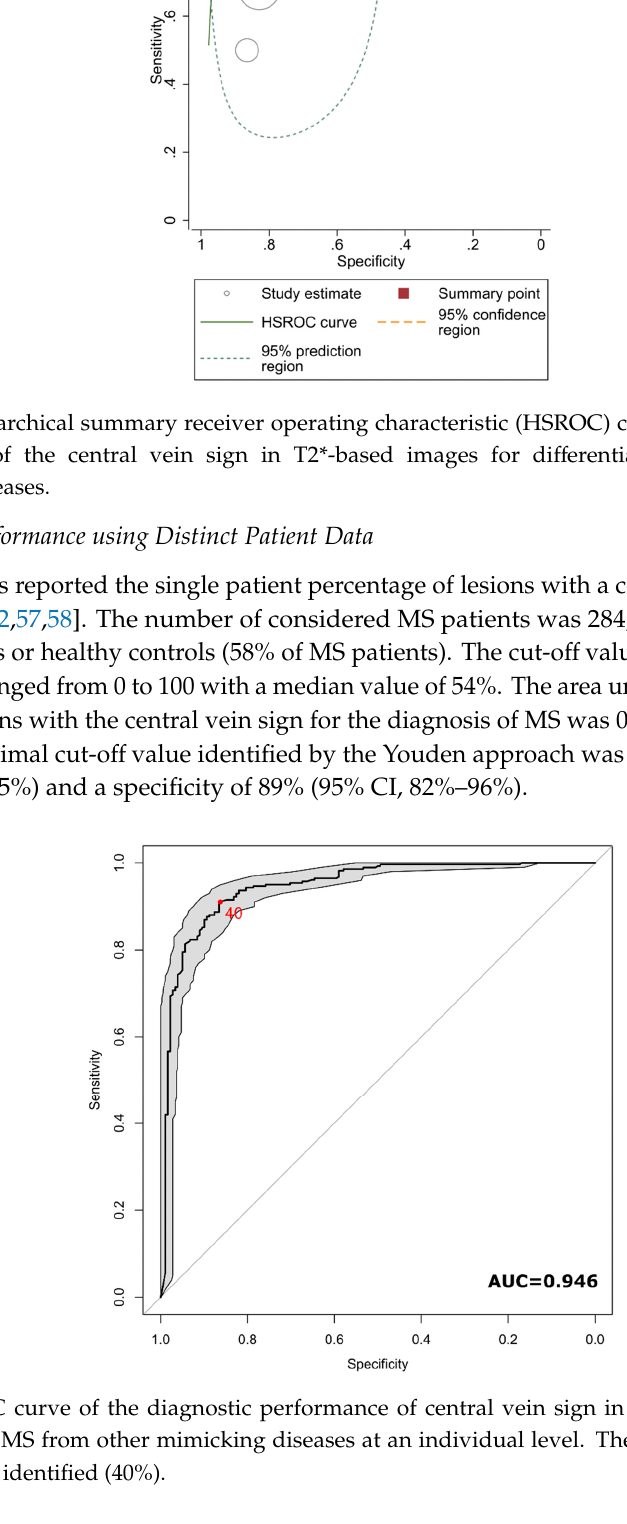
Figure 5. Forest plot of pooled specificity (in bold) of the central vein sign in T2*-weighted images for differentiating MS from other mimicking diseases. Specificity values are reported with estimated 95% confidence intervals (CIs) for each study included.